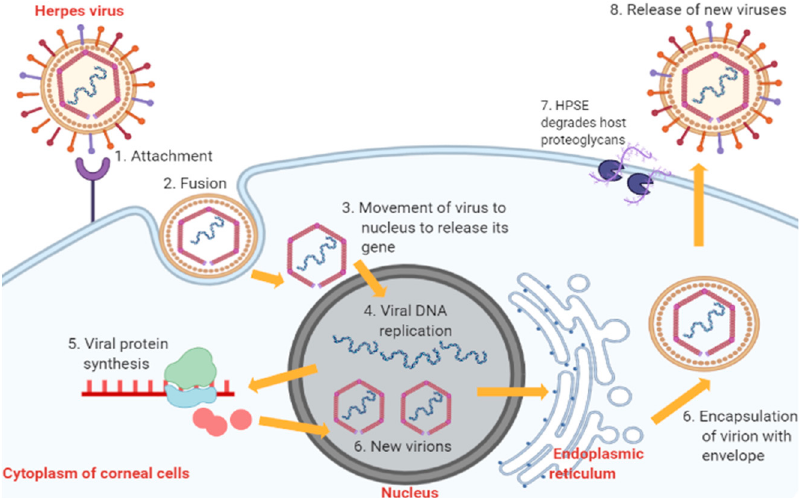
Figure 2. Stages of HSV-1 replication in corneal epithelial cells. Abbreviation: HPSE, heparanase, an enzyme which cleaves heparan sulfate proteoglycans to prevent virions from being trapped by the proteoglycans, thus promoting virion egress.